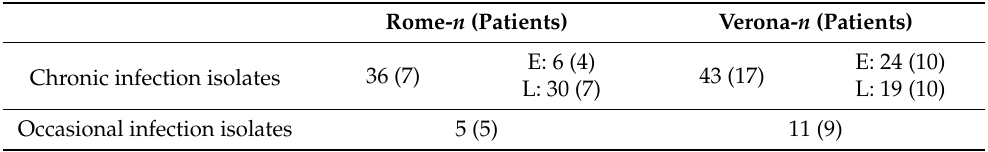
Table 2. Achromobacter spp. collections summary. The number of isolates included in each collection is reported in the table; the number of patients from which the strains were collected is indicated in parenthesis. E = early chronic infection isolates; L = late chronic infection isolates. Rome- n (Patients) Verona- n (Patients) Chronic infection